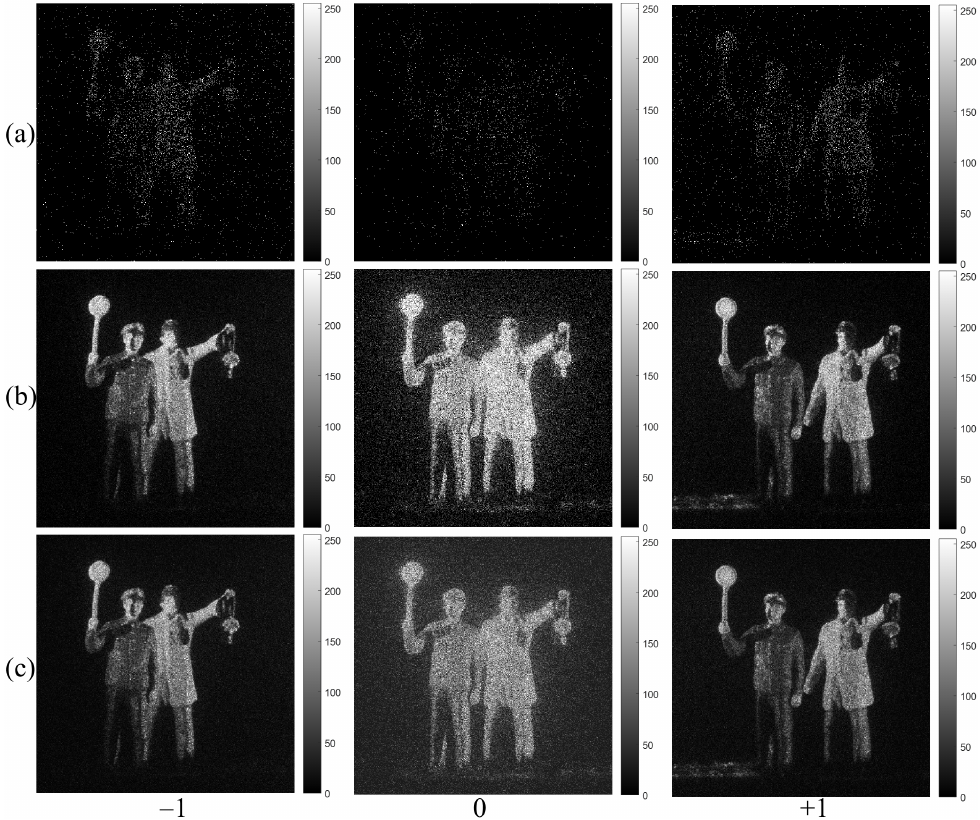
Figure 10. Diffraction images of Men objects by photon counting imaging with 1% photon ratio by ( a ) Single observation, ( b ) N = 100 observations of MLE, and ( c ) N = 100 observations of MAP, respectively.